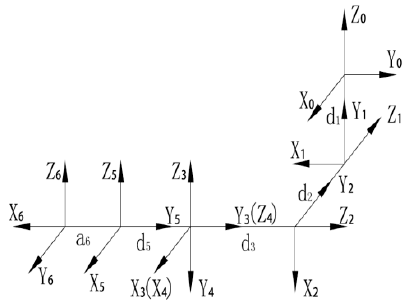
Figure 7. Denavit–Hartenberg (D-H) parameter model of robot. Table 2. D-H parameters of upper limb rehabilitation robot.